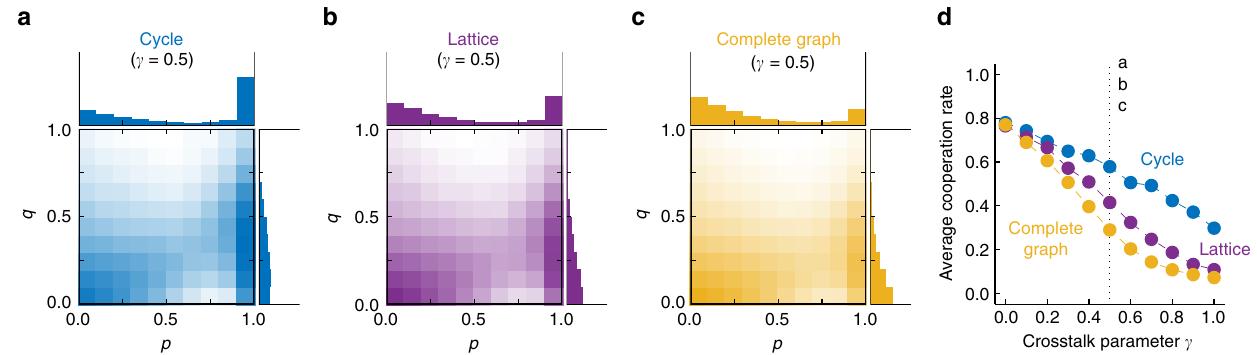
Fig. 4 Cooperative strategies evolve for various crosstalk rates and population structures. a – c Abundance of different reactive strategies ( p , q ) over the course of an evolutionary process when the crosstalk rate is fi xed to γ = 0.5. The probability to cooperate if the co-player in the previous round either cooperated or defected is denoted by p and q . On a cycle and a lattice, GTFT strategies evolved, whereas the same settings did not allow for the evolution of cooperative strategies on a complete graph. d Resulting average cooperation rates across different crosstalk rates. The dotted line indicates the crosstalk rate used in a – c . See “ Methods ” section for setup of the simulations. Parameter values: population size N = 16, bene fi t b = 10, cost c = 1,